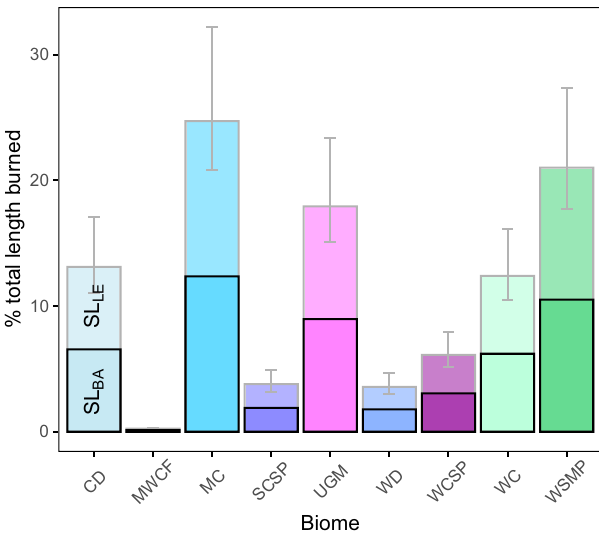
Fig. 4 Percentage of total stream + river length burned by ecoregion. Darker bars outlined in black on the bottom indicate the percent calculated from the quanti fi cation of the stream + river length impacted within burned areas (SL BA ), and lighter bars on the top represent our estimation of the longitudinal extent of stream + river length impacted by wild fi re disturbances (SL LE ). Error bars represent the 95% con fi dence interval associated with the fi t-line presented in supplementary Fig. 2. The ecoregion acronyms are Cold Deserts (CD), Marine West Coast Forest (MWCF), Mediterranean California (MC), South Central Semiarid Prairies (SCSP), Upper Gila Mountains (UGM), Warm Deserts (WD), West- Central Semiarid Prairies (WCSP), Western Cordillera (WC), Western Sierra Madre Piedmont